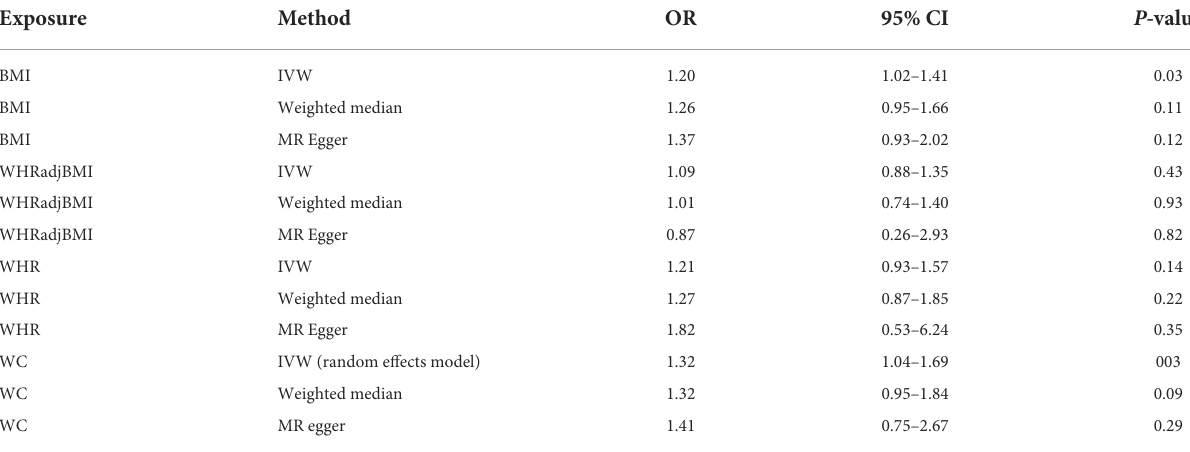
TABLE 1 Associations between BS and risk of glaucoma using Mendelian randomization. Exposure